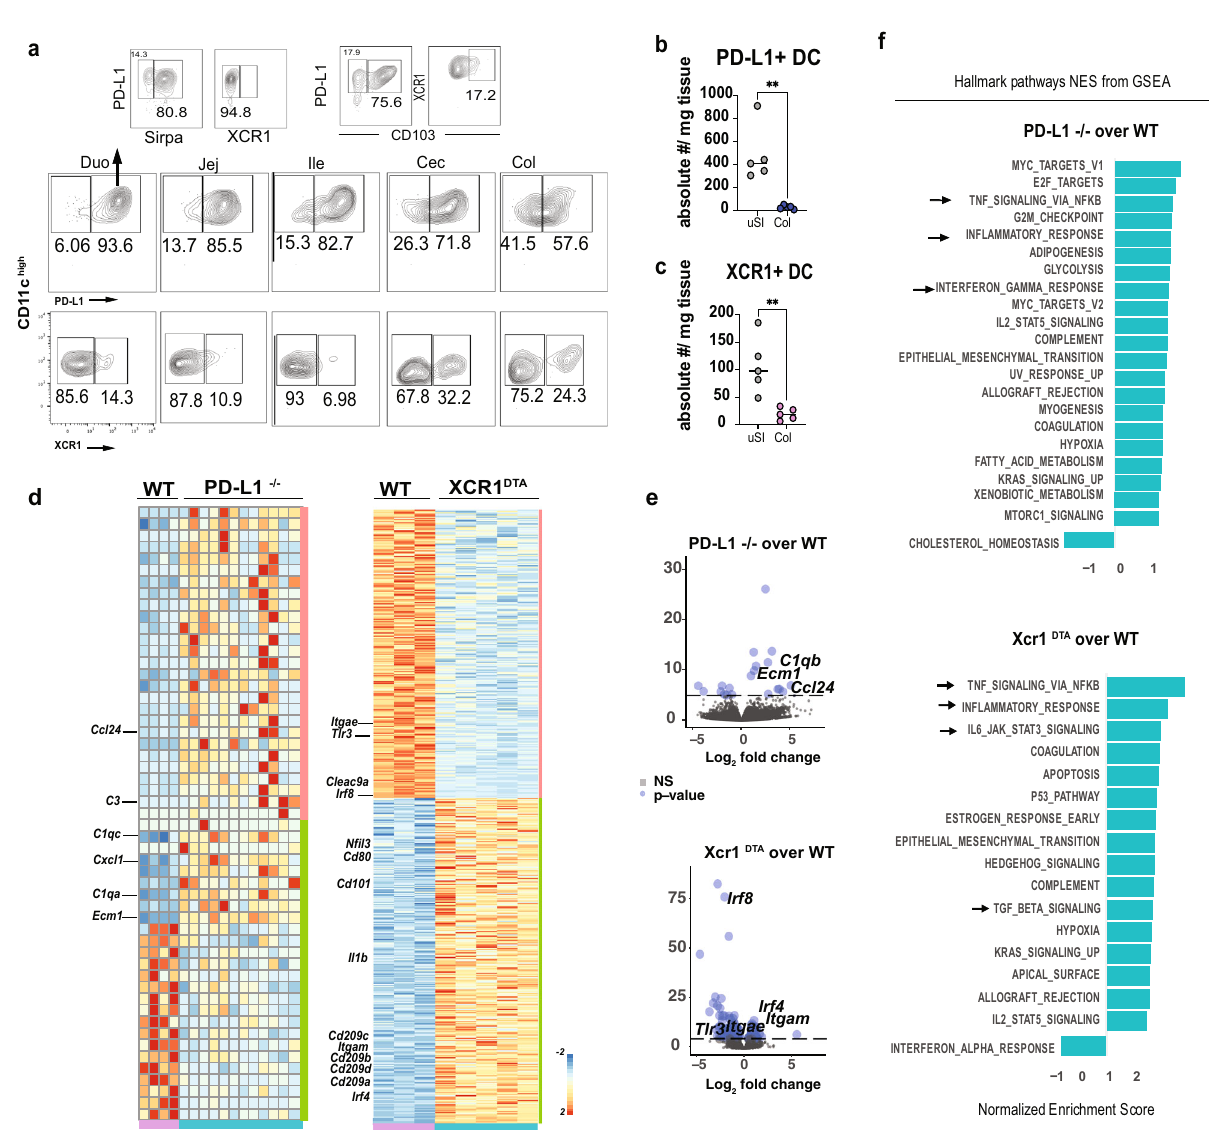
Fig. 4 Pro-in fl ammatory signature of intestinal DC lacking PD-L1 or XCR1. a Flow cytometry analysis of PD-L1 + , XCR1 + , Sirp α + , and CD103 + in LP DC from XCR1 venus mice in fi ve segments of the gut. b Absolute number of PD-L1 + and c XCR1 + DCs from C57BL/6 mice gated on singlets, live, CD45 + , dump − (CD19, B220, CD90.2, F4/80, CD64) CD11c + per gram of tissue upper Small Intestine (uSI) (duodenum and proximal jejunum) and colon (Col). N = 5 mice/group. Graphs represent mean ± SEM. Unpaired two-tailed Student ’ s t test. ** p = 0.003 (PD-L1), ** p = 0.005 (XCR1). d – f Heatmap ( d ), volcano plot ( e ), and Gene Set Enrichment Analysis (GSEA) pathways ( f ) of modulated genes found in RNA-seq analysis from DCs sorted from uSI LP of Pd-l1 − / − and littermate controls, and colonic LP of XCR1 DTA and littermate controls. N = 3 of a pool of N = at least three mice over at least three independent experiments. Source data are provided as a Source Data fi le. Wild-type (WT); gene set enrichment analysis